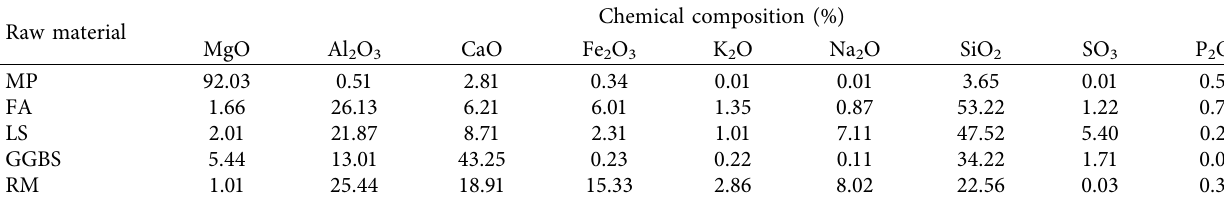
Figure 1: SEM observation of raw materials: (a) MP; (b) FA; (c) LS; (d) GGBS; and (e) RM. Table 1: Chemical compositions of raw